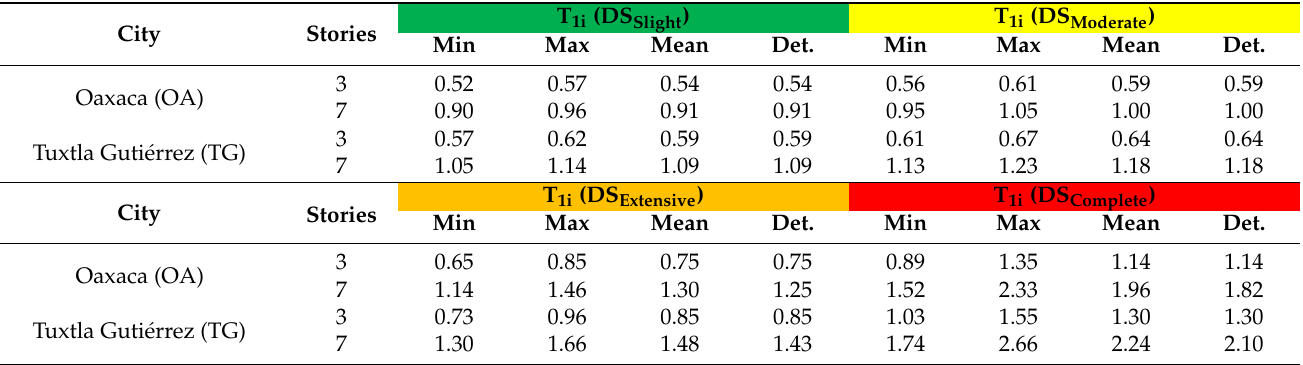
Table 7. Minimum, mean, maximum probabilistic, and deterministic values of the T 1i for each DS non-null from the Risk-UE guideline in the buildings.